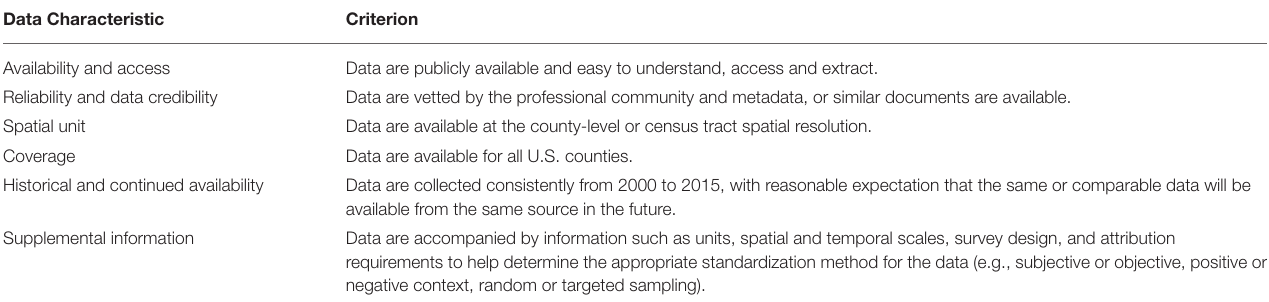
TABLE 2 | Data acceptance criteria used to identify and select